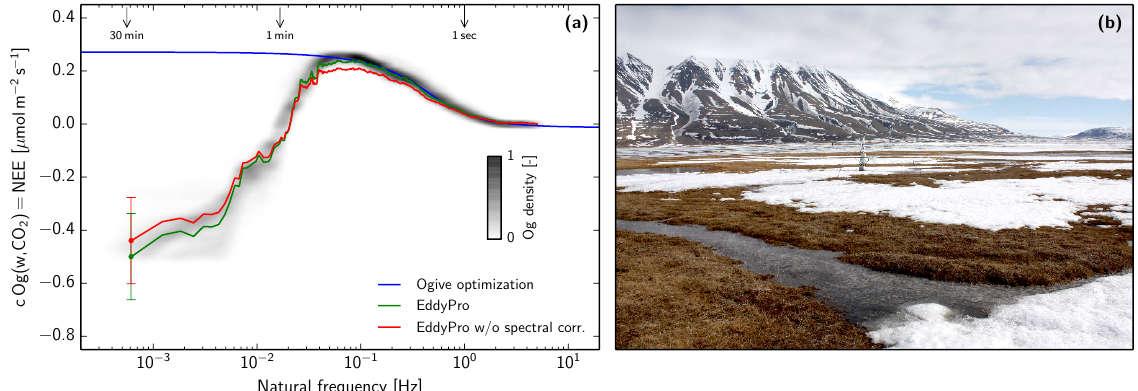
Figure 2. Example of the CO 2 flux estimation during snowmelt. (a) Ogive on 31 May 2015 at 15:00LT showing a mismatch between low and high frequencies. While ogive optimization estimates a net CO 2 release, EddyPro (with and without spectral corrections after Moncrieff et al., 1997, 2004) indicates an uptake. Average horizontal wind speed 5.2ms − 1 from NW (313 ◦ ), air temperature 4.5 ◦ C, quality flag 0. The arrows on the top indicate the corresponding timescales. (b) Photo of the environment around the flux tower on 27 May 2015 at 12:00LT during